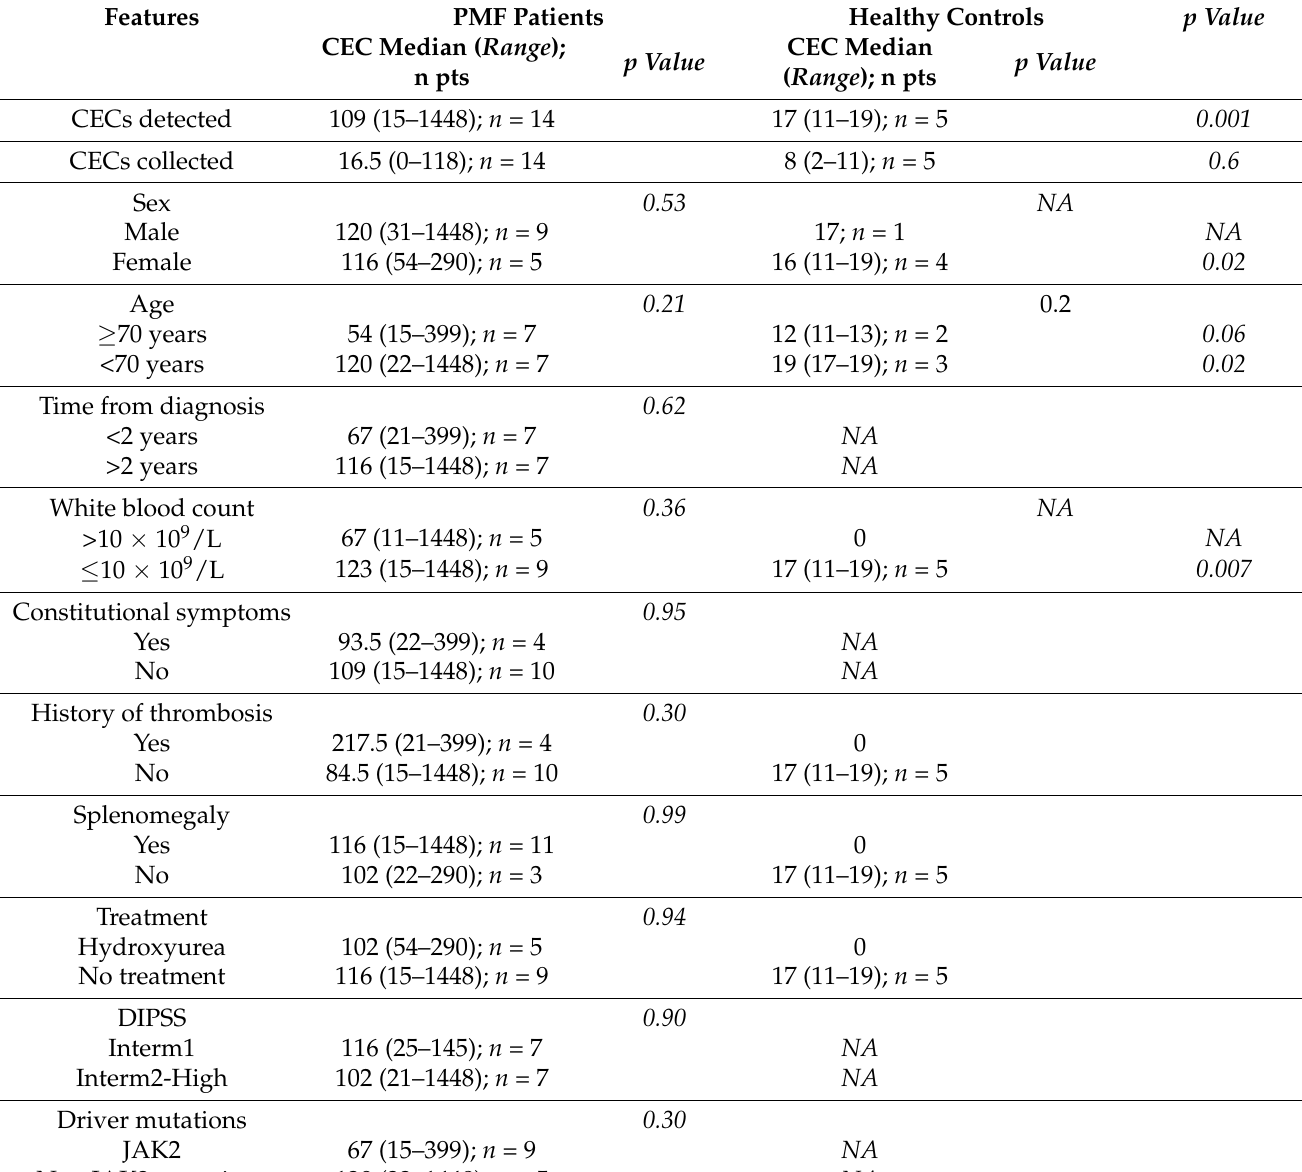
Table 2. Impact of the patients’ characteristics on the CECs